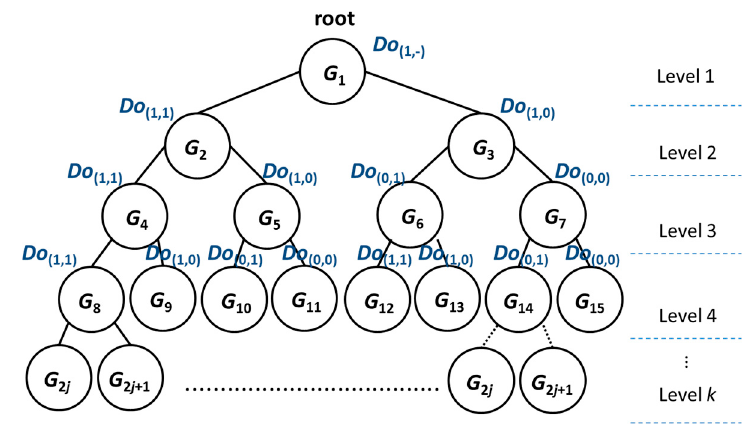
Figure 3. MADAG tree.